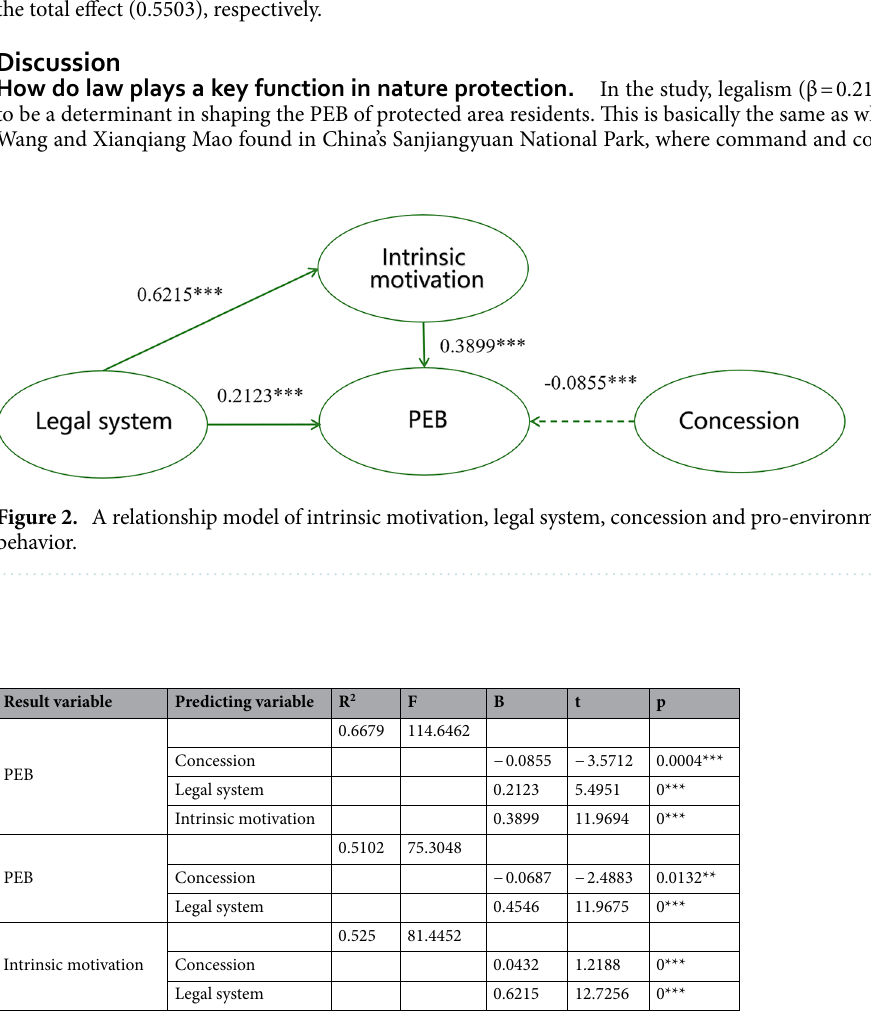
Table 3. Testing and effect analysis of Intrinsic motivate on mediational model. **p < 0.05. ***p <